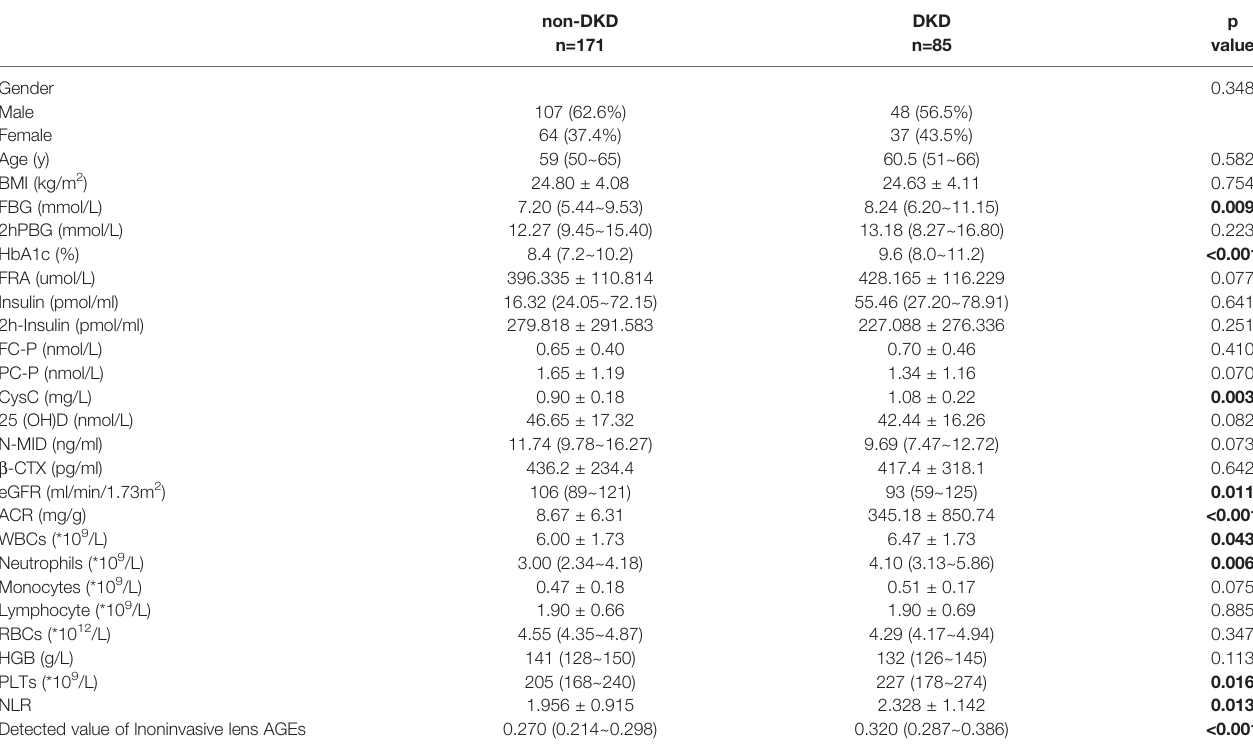
TABLE 3 | Paired case-control study of non-DKD and DKD.